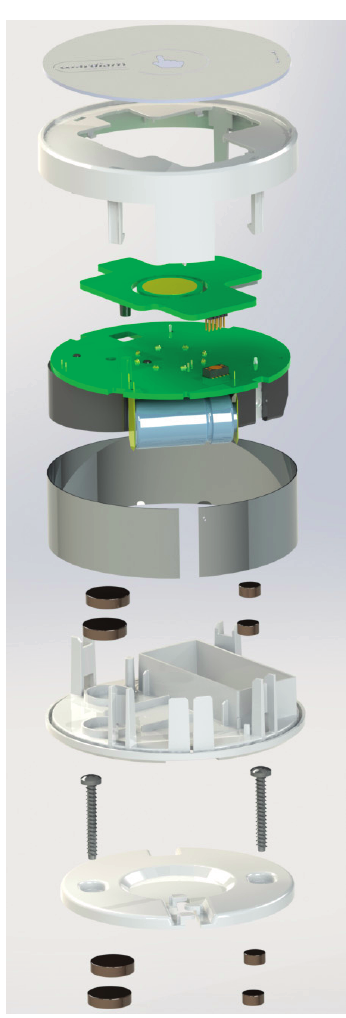
Figure 10. Detail of the fabrication of the entire wireless smoke